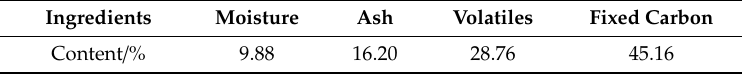
Table 3. General analysis of the bitumite.